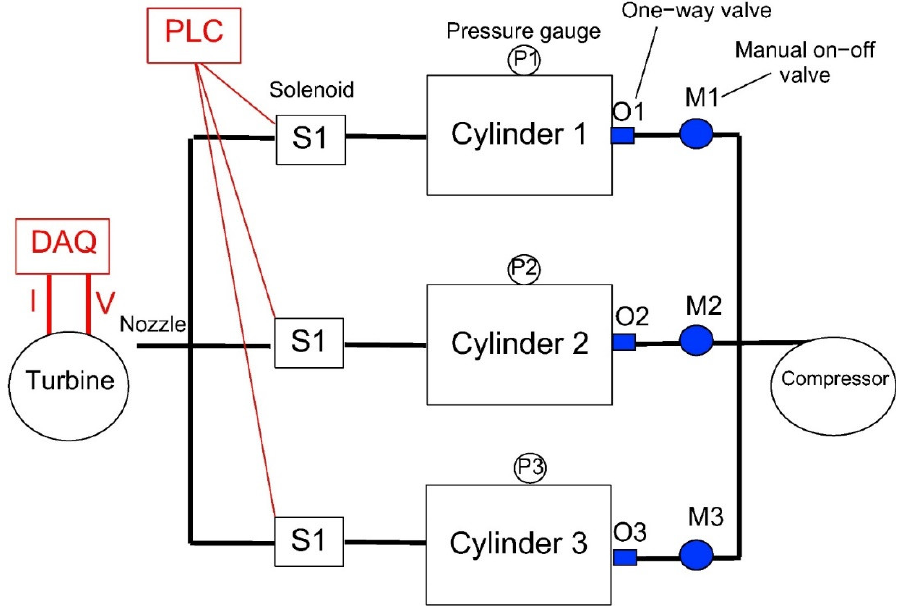
Figure 14. Main components of the modular low-pressure micro-CAES [146].